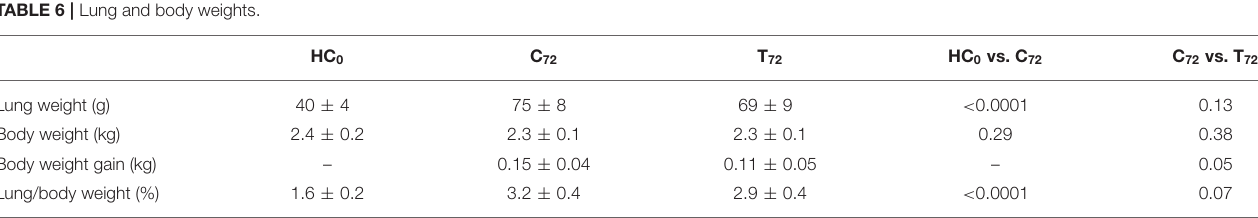
TABLE 6 | Lung and body weights.